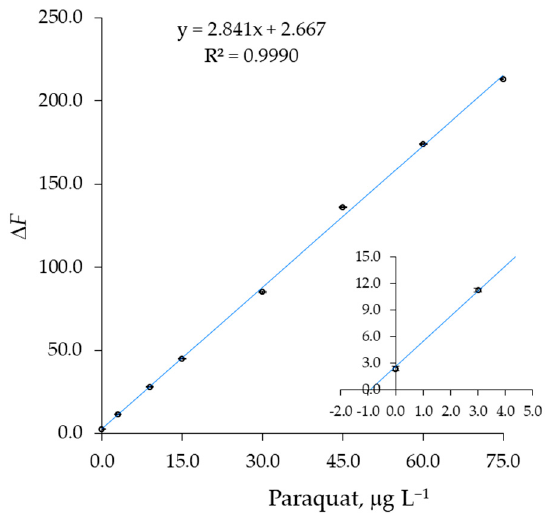
Figure 11. Standard additions plot obtained by adding a methanol solution of paraquat, PQ, and 1b to a tap water sample (3 replicates). The sample was divided into 8 equal aliquots. The spike concentration of 1.0 µ g L − 1 was normalized to the total volume of solvent, 60/40 methanol/water. Inset: The straight line intersects the x-axis to the expected concentration of (1.1 ± 0.1) µ g L − 1 of PQ. Table 8. Experimental data for the standard additions plot reported in Figure 11. V 1b and V PQ are the added volumes of the standard methanol solutions of [1b] = 2500 µ g L − 1 and [PQ] = 1500 µ g L − 1 , respectively. A tap water sample was spiked and divided into 8 aliquots. The spike concentration of 1.0 µ g L − 1 was normalized to the total volume of 2500 µ L, 60/40 methanol/water.